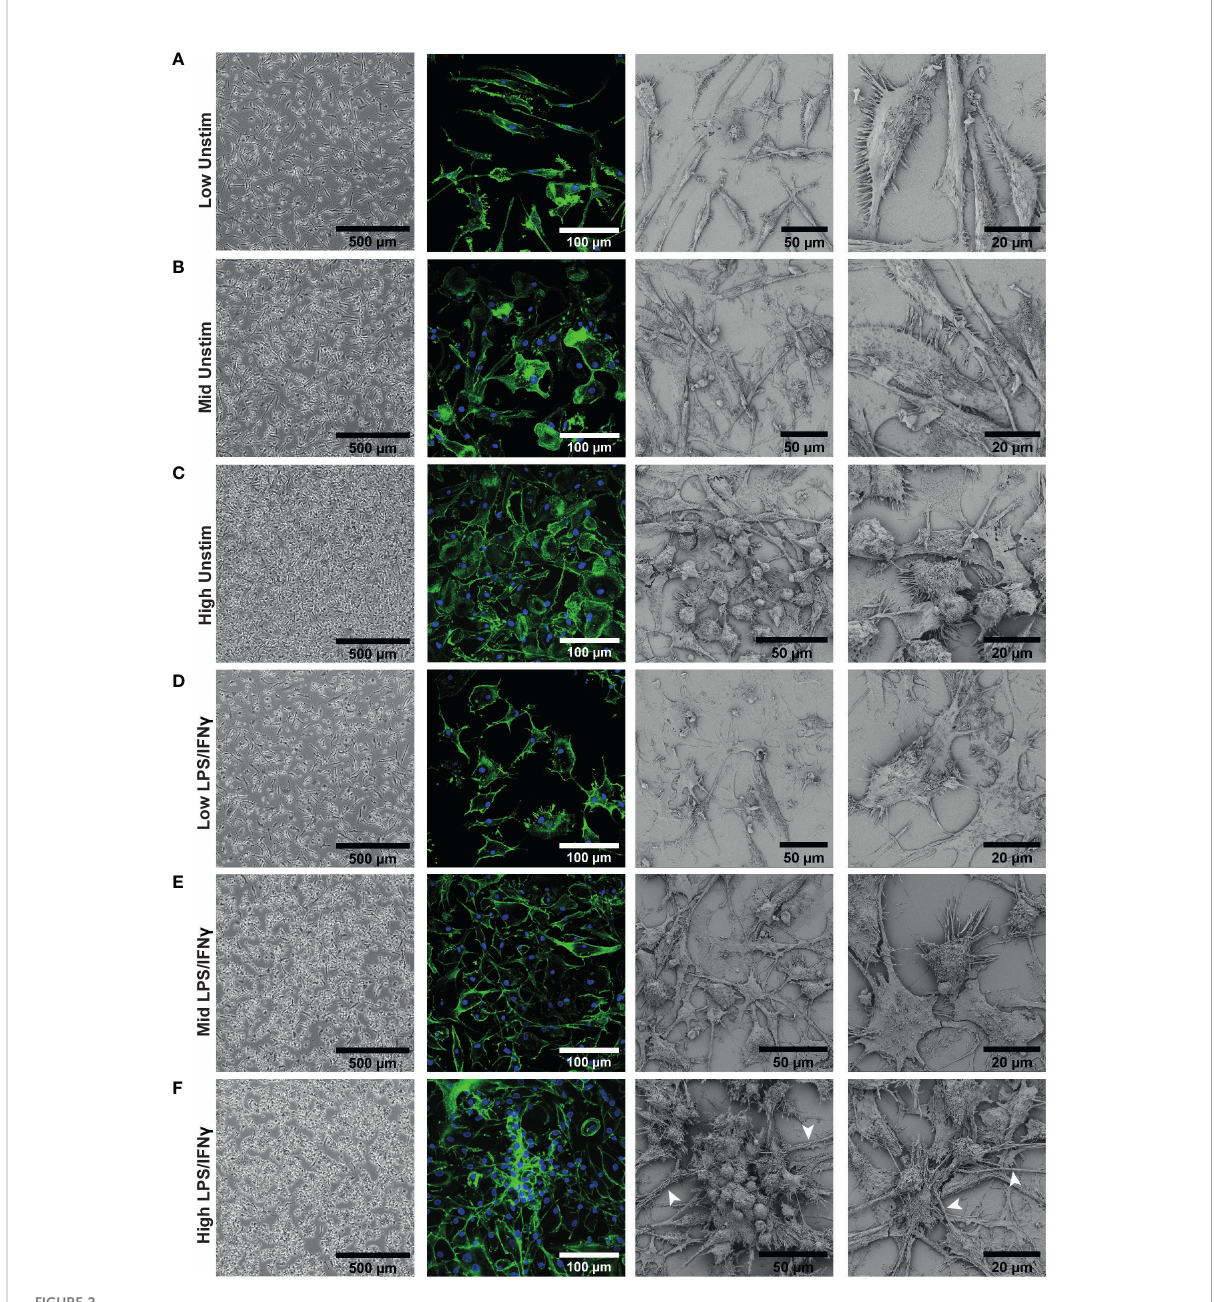
FIGURE 2 iPSC-Macs plated at different densities have different morphologies. Representative images of iPSC-Mac: Far left; bright fi eld with no fi xation or staining. Middle left; confocal, 40x magni fi cation, stained for nuclei (DAPI, blue) and actin (Phalloidin, green). Right; Scanning EM. (A – C) Unstimulated cells. (D – F) iPSC-Macs 24 hours after M1 polarization. (F) Arrows indicate potential tunnelling nanotube-like